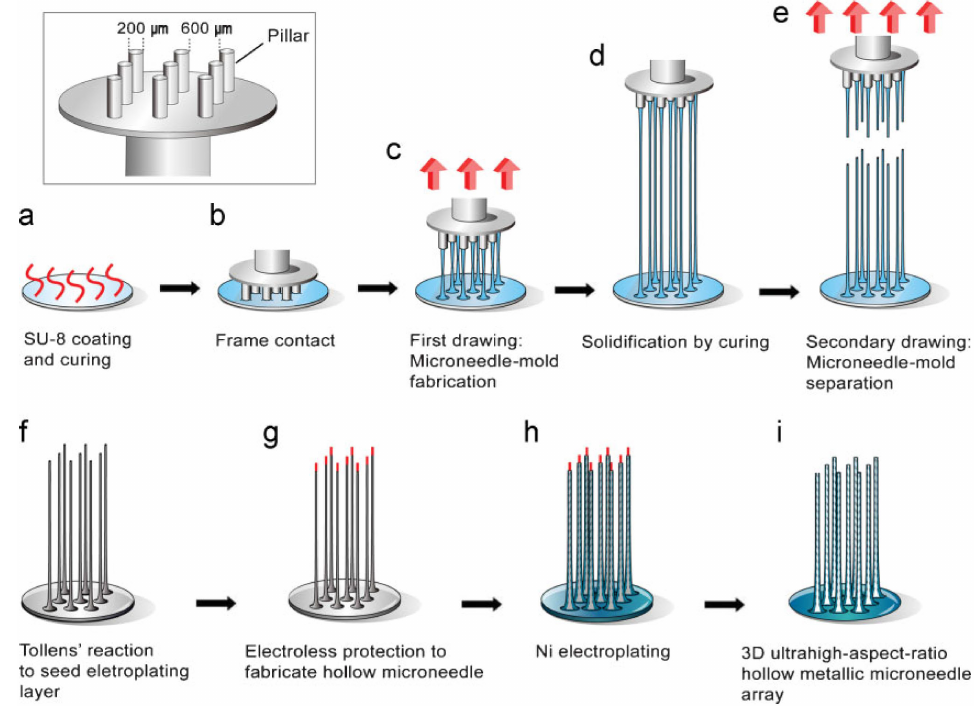
Figure 10. Schematic diagrams of the process sequence of the SU-8 drawing lithography: ( a ) SU-8 spin coating; ( b ) stainless drill pillar array contact; ( c ) drawing of SU-8 layer; ( d ) thermal cross-linking of drawn SU-8; ( e ) second drawing to create microneedle array; ( f ) electroplating seed layer preparation; ( g ) protection at the tips of the microneedles; ( h ) electroplating; and ( i ) hollow microneedle formation by removing SU-8 and tip protection layer. Reprinted with permission from [37], copyright 2010 WILEY-VCH Verlag GmbH & Co. KGaA,